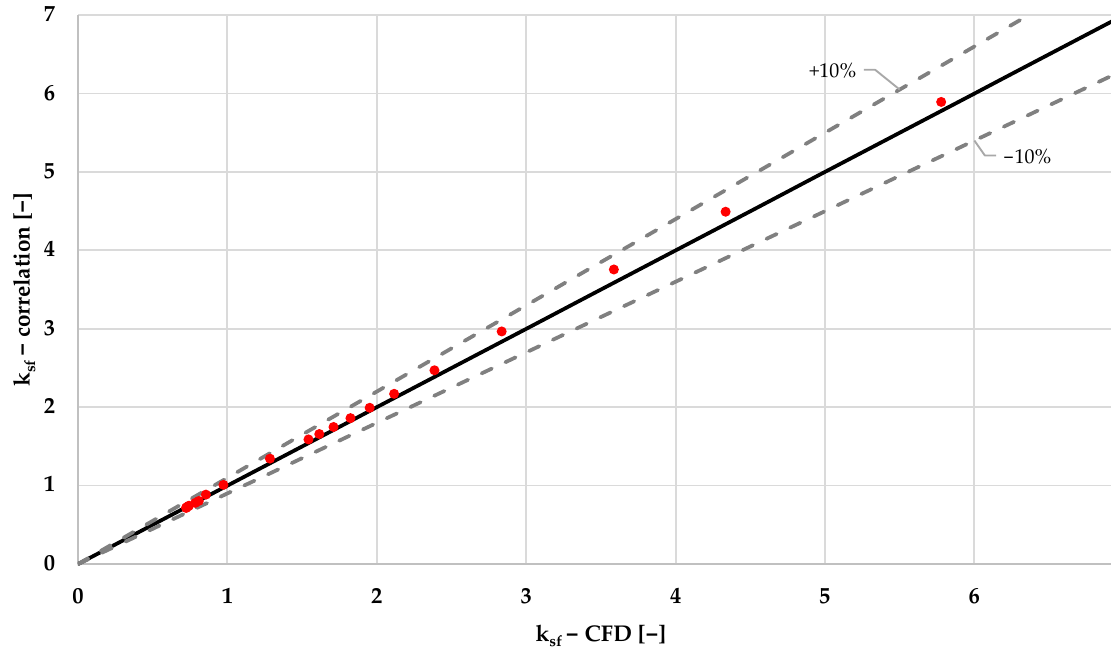
Figure 6. CFD vs. analytical k sf of local pressure drop for single-phase simulations.